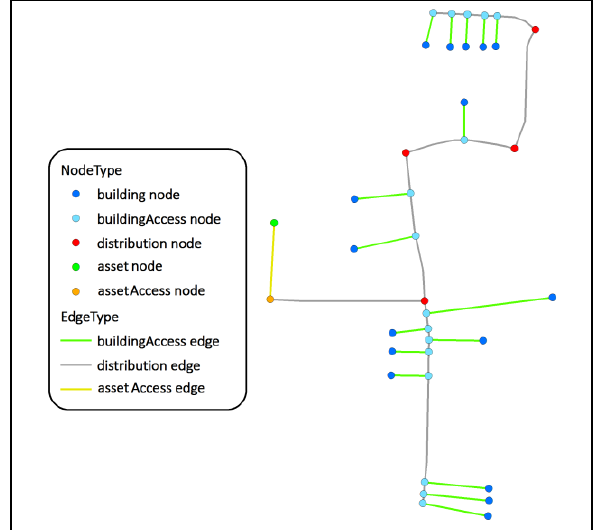
Figure 7. Different types of nodes and edges in an infrastructure network (Contains OS data © Crown copyright and database right